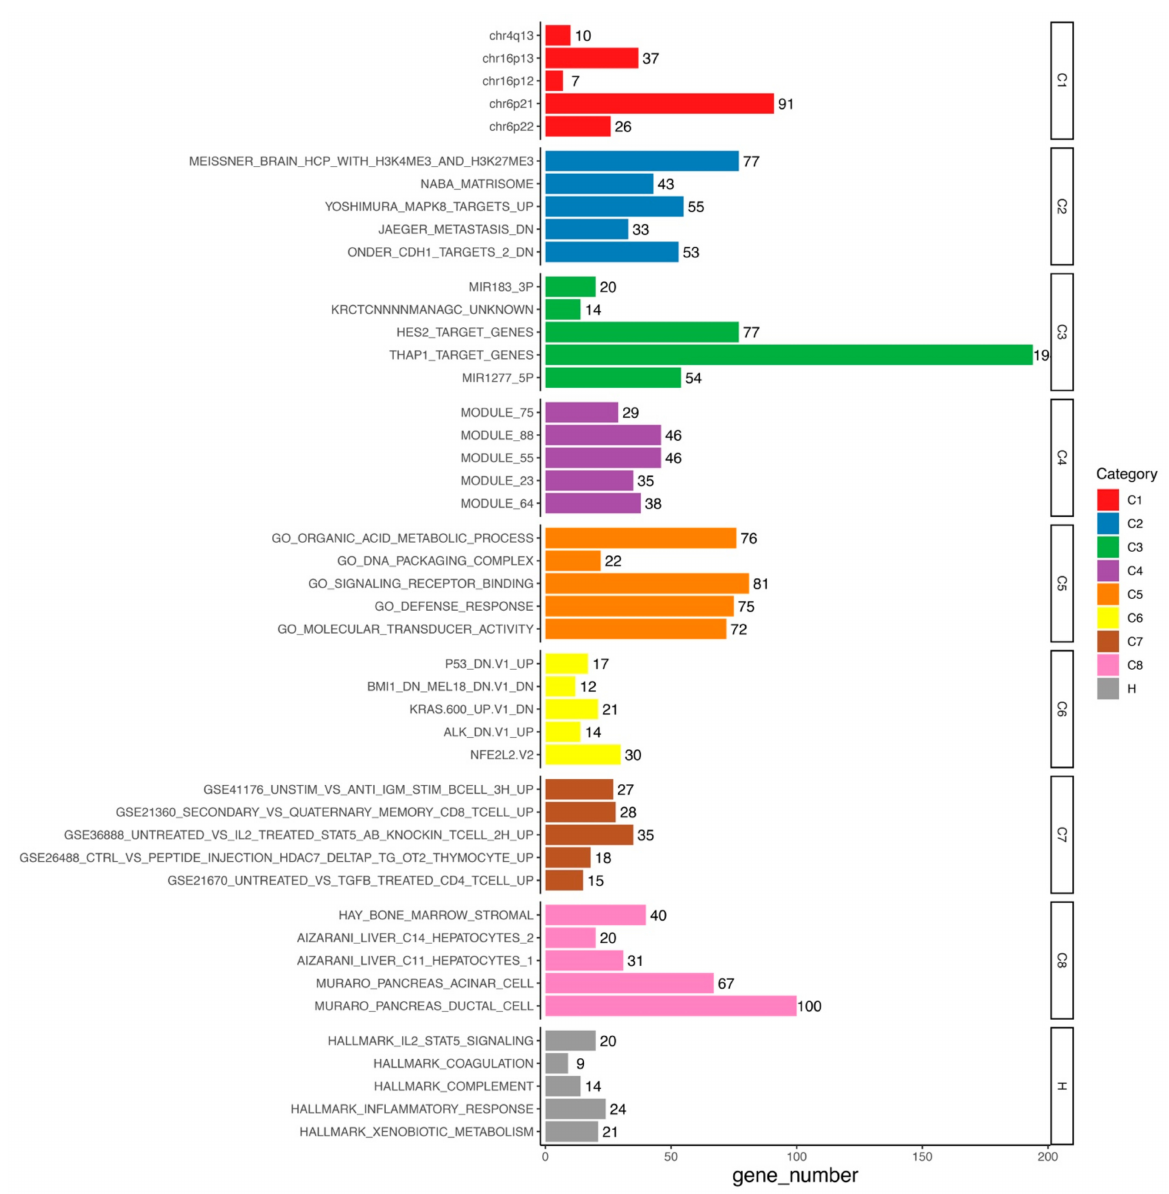
Figure 8. Functional enrichment of